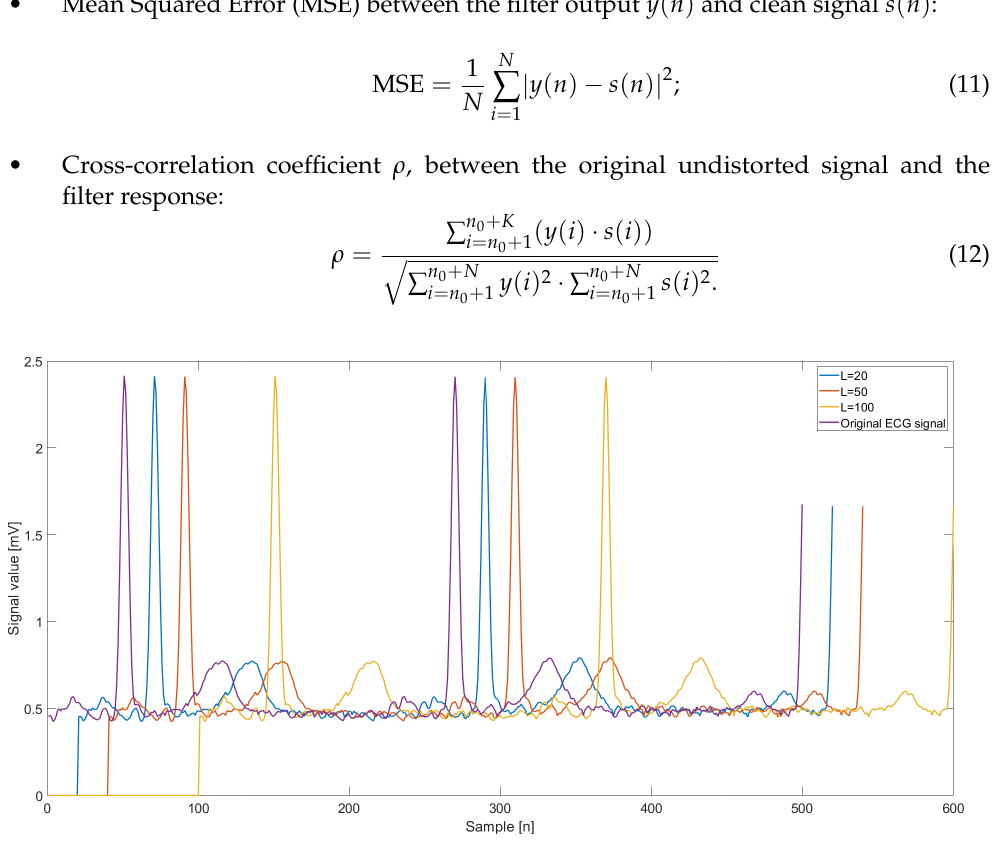
Figure 1. Comparison of the filter responses for different values of L in the classical vector projection method from the article